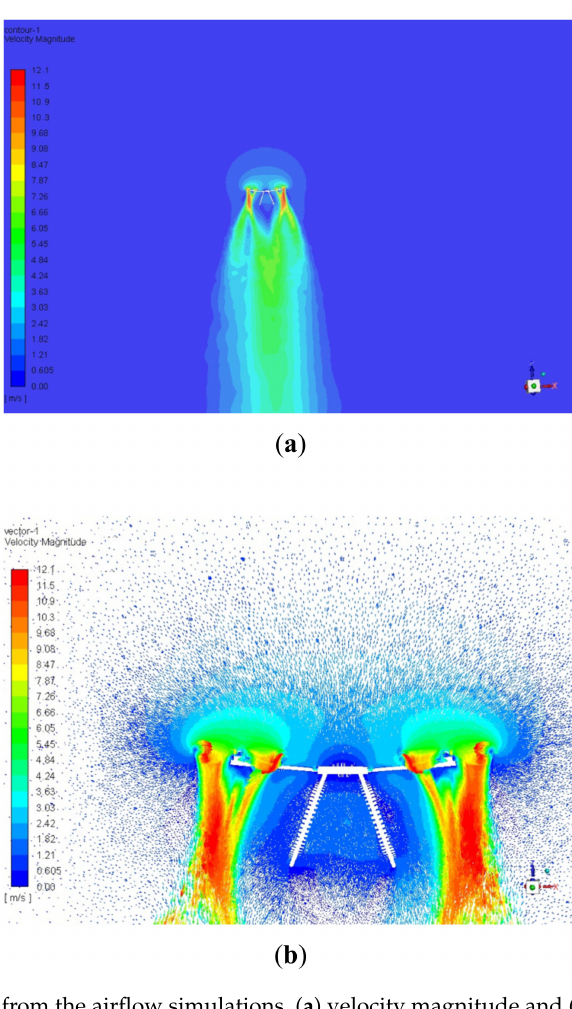
Figure 5. Results from the airflow simulations, ( a ) velocity magnitude and ( b ) velocity vector.